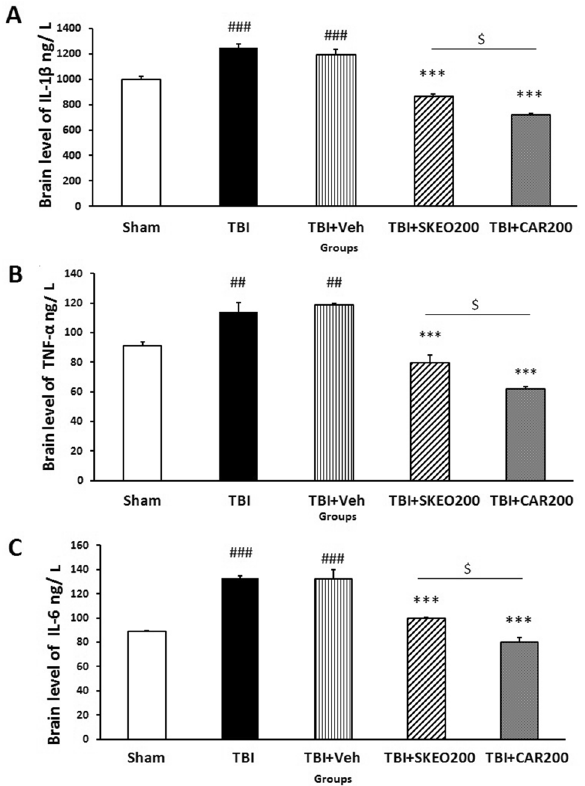
Figure 4. Effects of SKEO and CAR on the ( A ) IL-1β, ( B ) TNF-α, and ( C ) IL-6 levels 24 h after TBI induction in the different experimental groups (n = 6 rats per group). Data are expressed as mean ± SEM. ## P < 0.01 & ### P < 0.001 represent significant differences with sham; *** P < 0.001 represents significant difference with TBI + Veh; and $ P < 0.05 represents significant difference between TBI + CAR and TBI + SKEO. TBI: Traumatic brain injury; SKEO: Satureja khuzistanica essential oil; CAR: